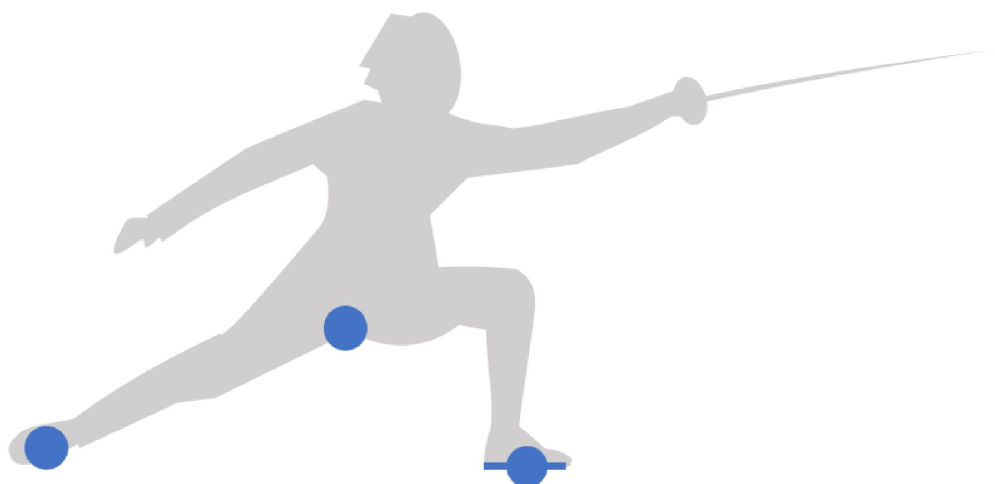
Fig 7. Footwork space. It is defined by the back foot, the crotch and the front foot. It captures important locomotion movements in the sagittal plane, such as step forward, step backward or lunge attack.